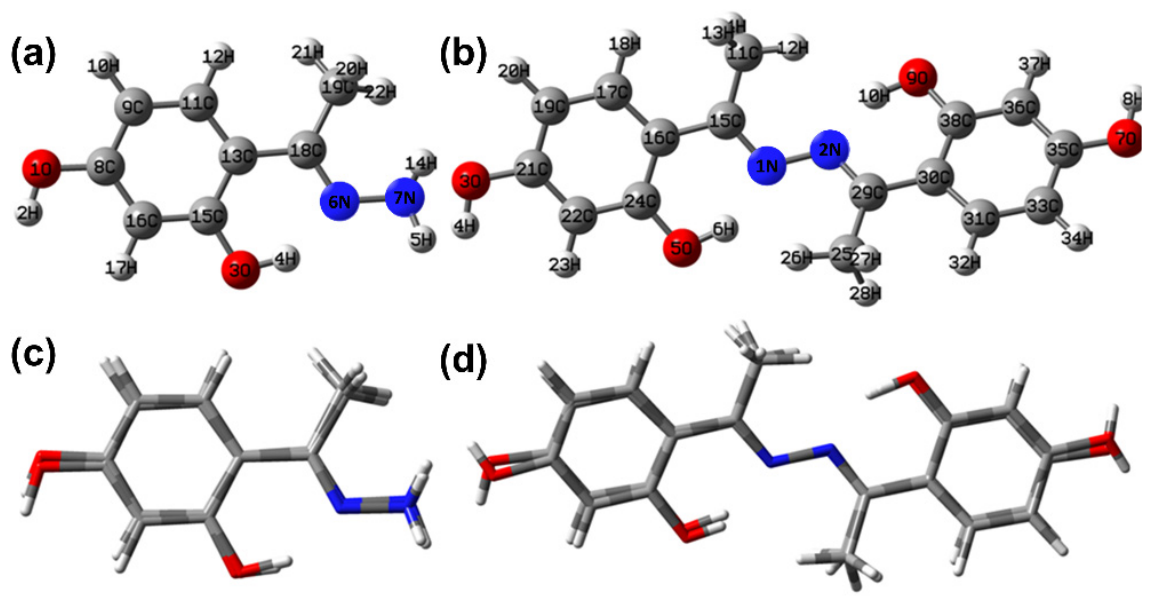
9 of 15 Figure 3. Packing diagram of compound 2 having two different molecules in the asymmetric unit. The quantum mechanically computed structures of compounds 1 and 2 were ob- tained based on their crystallographic data at the 6.31G(d,p) level using the DFT/B3LYP method in the gas phase (Figure 4). The optimized geometry was checked as minima on the potential energy surfaces by calculating the vibrational frequency at the same level of theory, which showed no negative frequency. The global energy minimum obtained for compounds 1 and 2 were − 570.8129 and − 1029.7542 Hartree with the dipole moment of 2.6255 and 0.6732 Debye, respectively. The C1 symmetry point group was observed for both compounds. To make a direct comparison, the DFT computed geometric parameters of 1 and 2 are summarized in Table 3 with their corresponding experimental values ob-